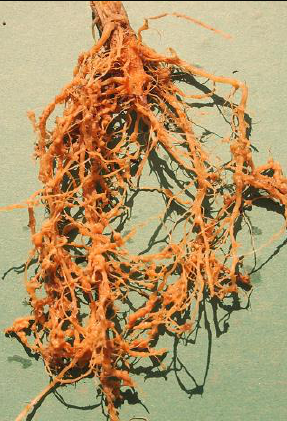
Figure 2. Galling on roots of cucurbit species caused by root-knot nematode.